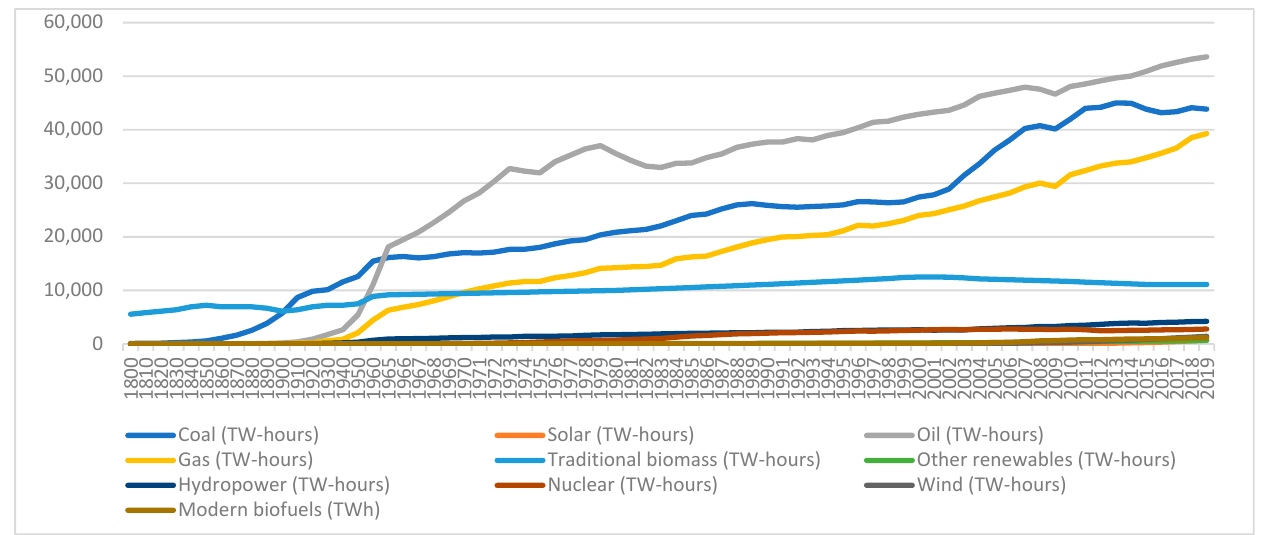
Figure 1. Worldwide energy consumption by fuel, between 1800–2017. Own representation adapted from data [42].